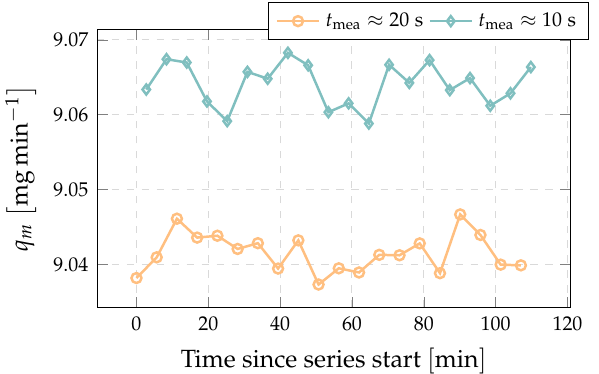
Figure 6. Example of consecutively measured flow rate with alternating fill time and without time ≈ 0.2 s and t I → II ≈ 0.6 s). correction ( t II → I div div